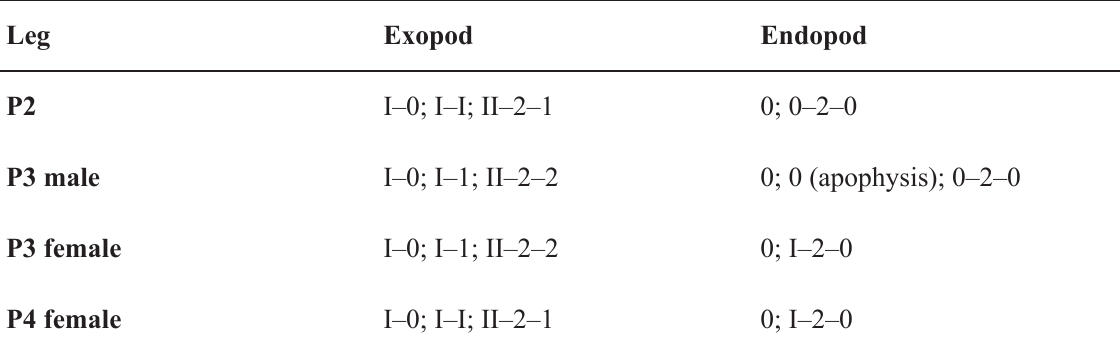
Table 2. Paratouphapleura aaroni gen. et sp. nov., setation of swimming legs P2–P4; Roman numerals indicate outer, Arabic numerals inner